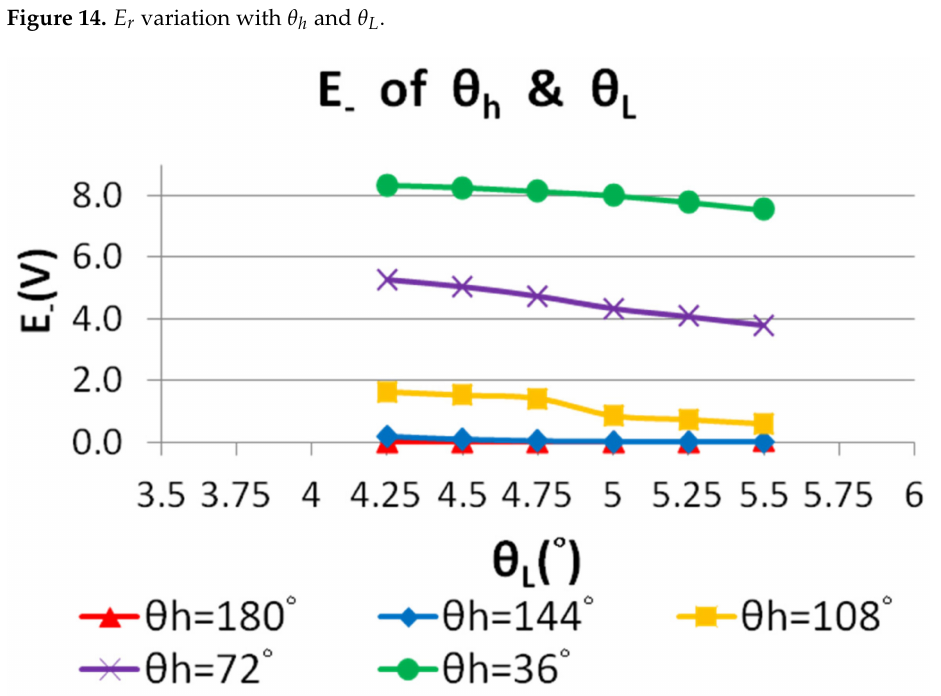
Figure 14. E r variation with θ h and θ L .